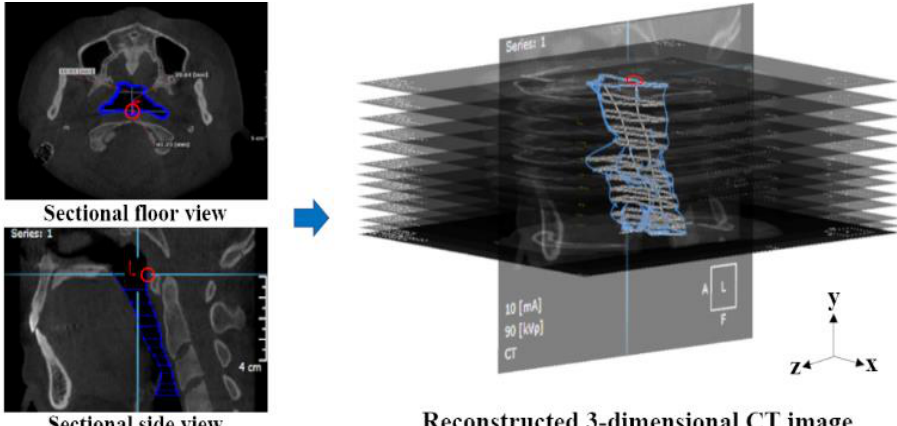
Figure 1. Procedure of the 3D reconstruction of upper airway based on sectional CT images. The complex shape of airway in sectional floor CT view was manually designed. To use the lofted boss/base in SolidWorks software, the edges of airway were manually matched on the sectional floor and side views.